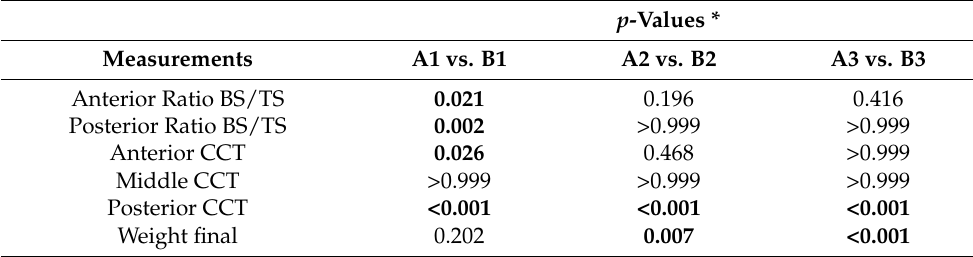
Table 6. Pairwise group per timing measurements comparisons’ p -values derived from linear regres- sion models and adjusted for multiple comparison (Bonferroni).